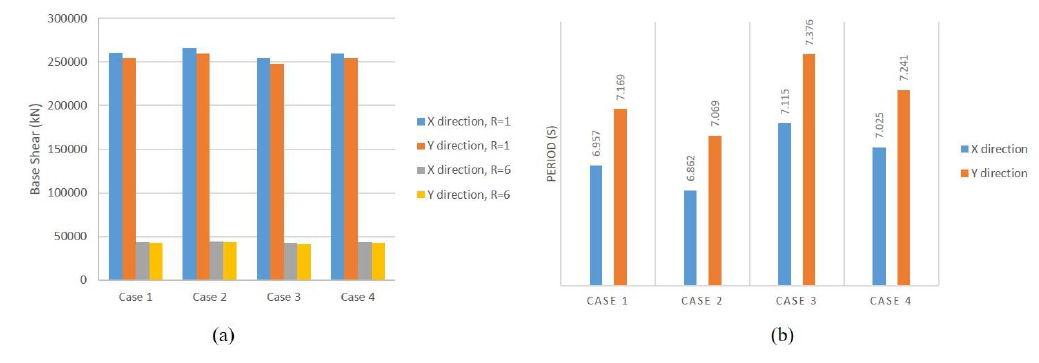
Fig. 9. a) Base shears, and b) Periods.